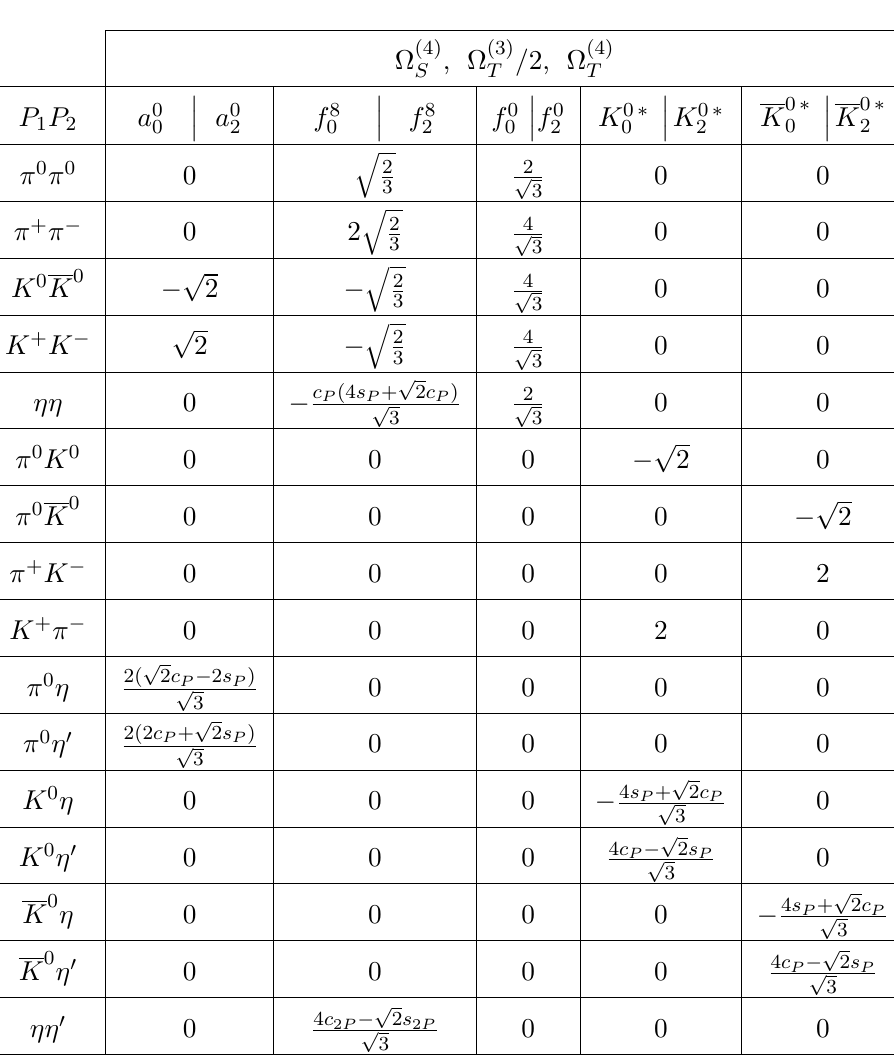
, Ω (3) and Ω (4) S T T